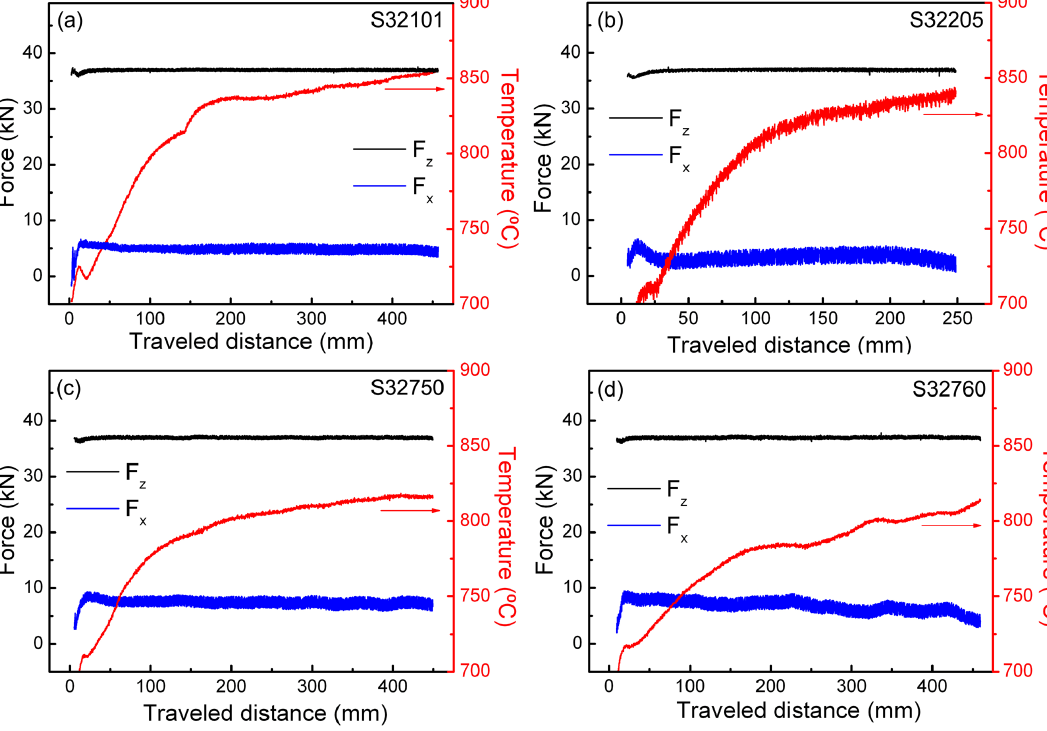
Fig. 6. Evolution of downward force (Fz), force in the welding direction (Fx), and tool temperature: (a) S32101, (b) S32205, (c) S32750, and (d)